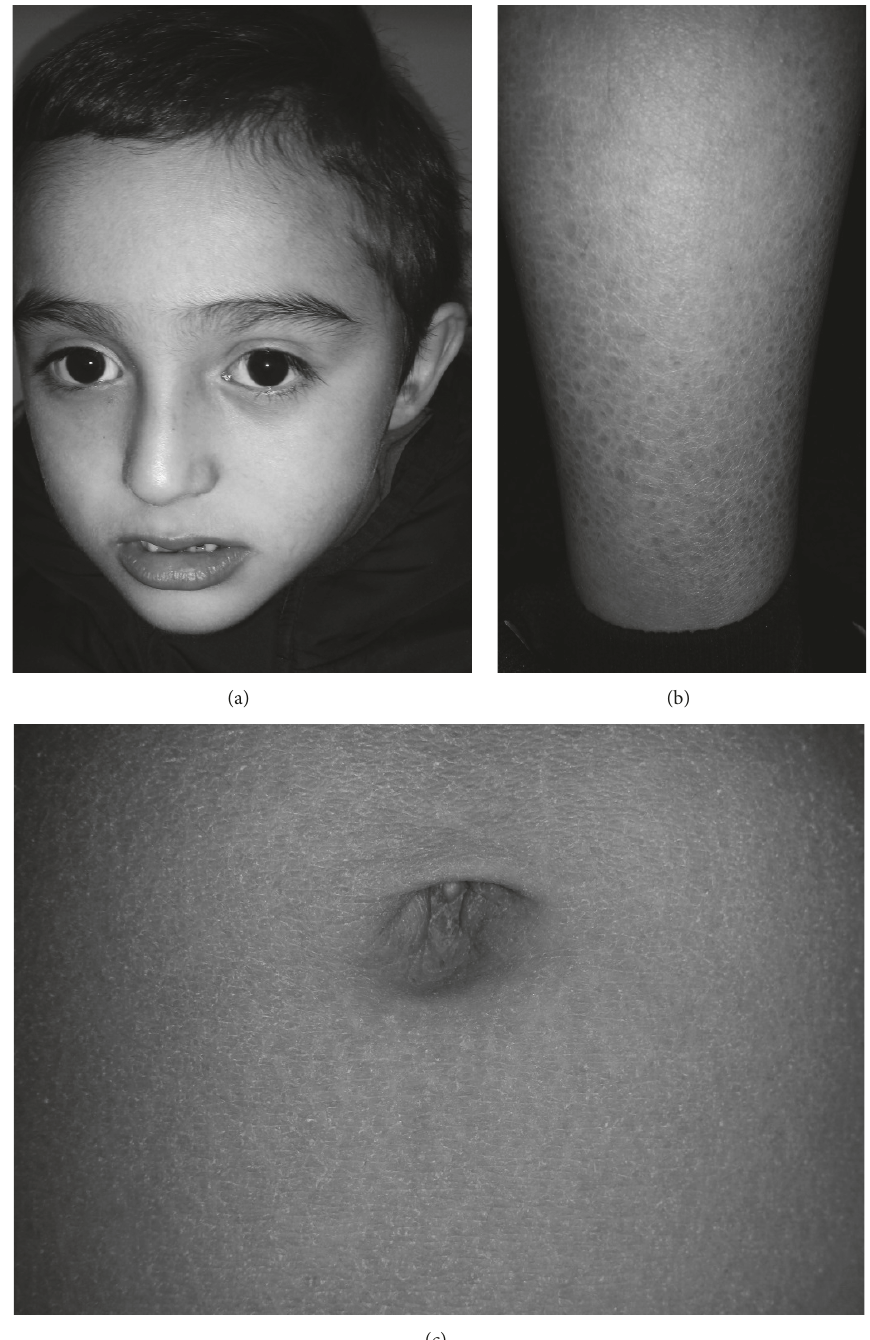
Figure 1: (a) Facial features include the high anterior hairline, a triangular face, a short chin, widely spaced eyes, and prominent nasal bridge. The dry, scaly skin was observed in (b) the pretibial areas and (c) the